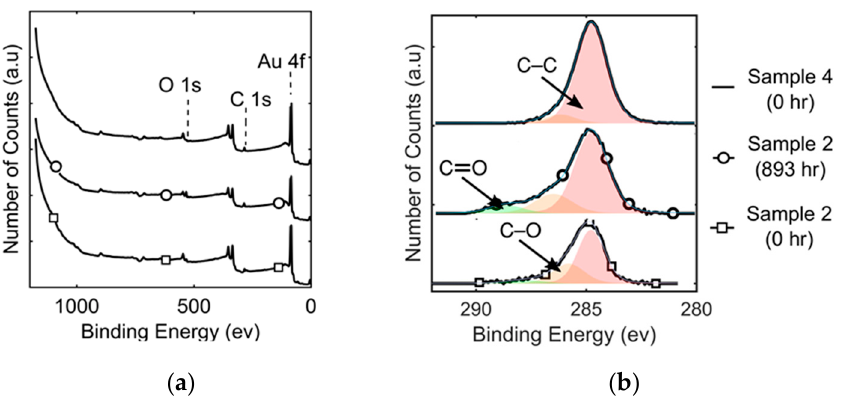
Figure 3. ( a ) Broad-range energy scan and ( b ) high-resolution XPS spectra of sample 2 (exposure time of 0 and 893 h) and sample 4 (exposure time of 0 h).